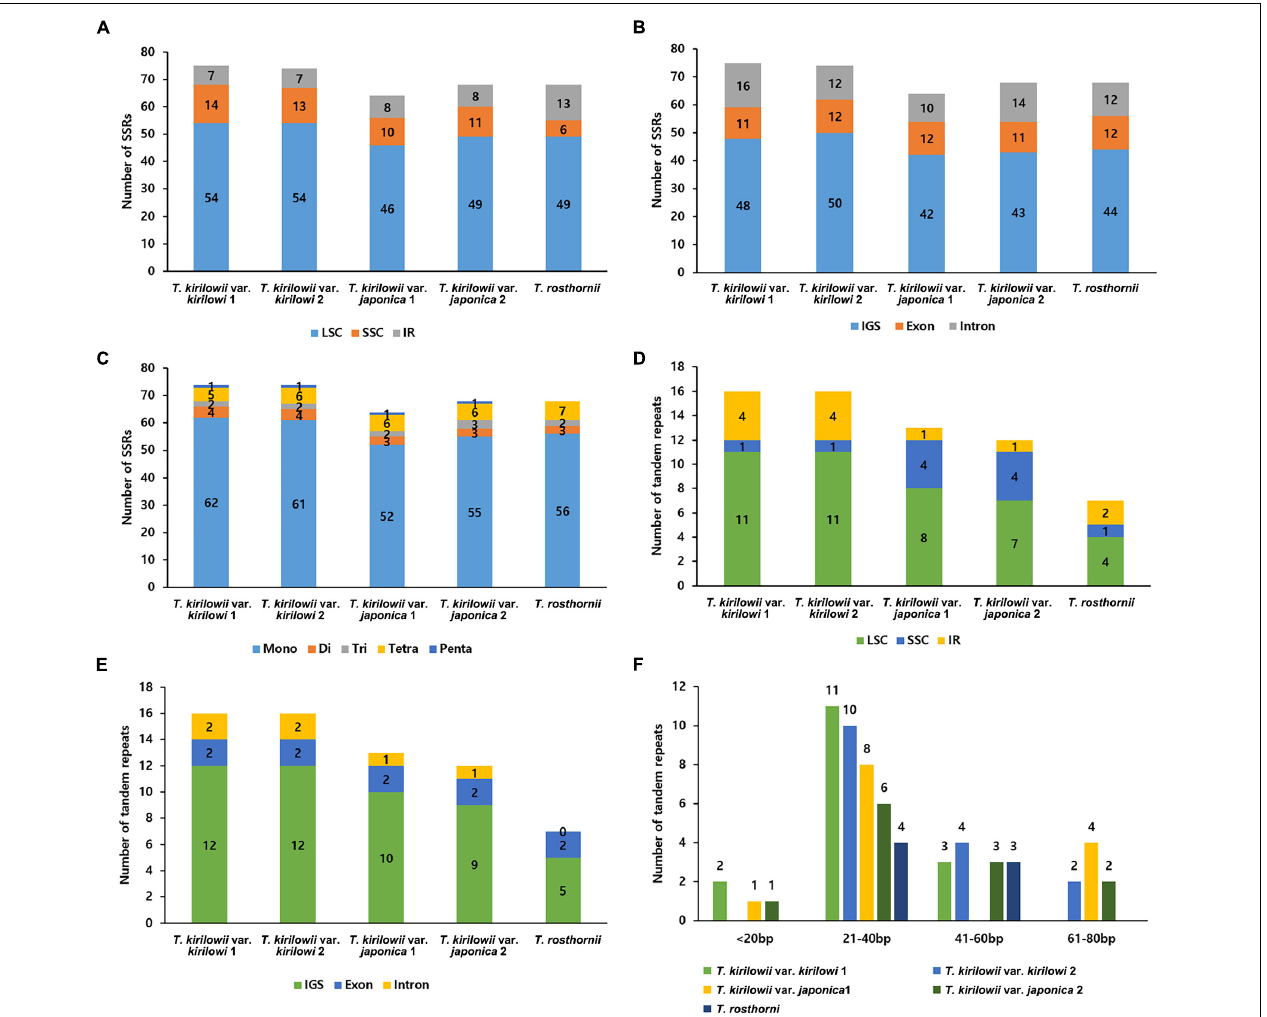
FIGURE 3 | Distribution of repeat sequences in the five Trichosanthes plastid genomes. (A) Number of SSRs in genomic regions. (B) Distribution of SSRs in intergenic spacer (IGS), exon, and intron regions. (C) Distribution of SSR types. (D) Distribution of tandem repeats in genomic regions. (E) Distribution of tandem repeats in intergenic spacer (IGS), exon, and intron regions. (F) Distribution of tandem repeat